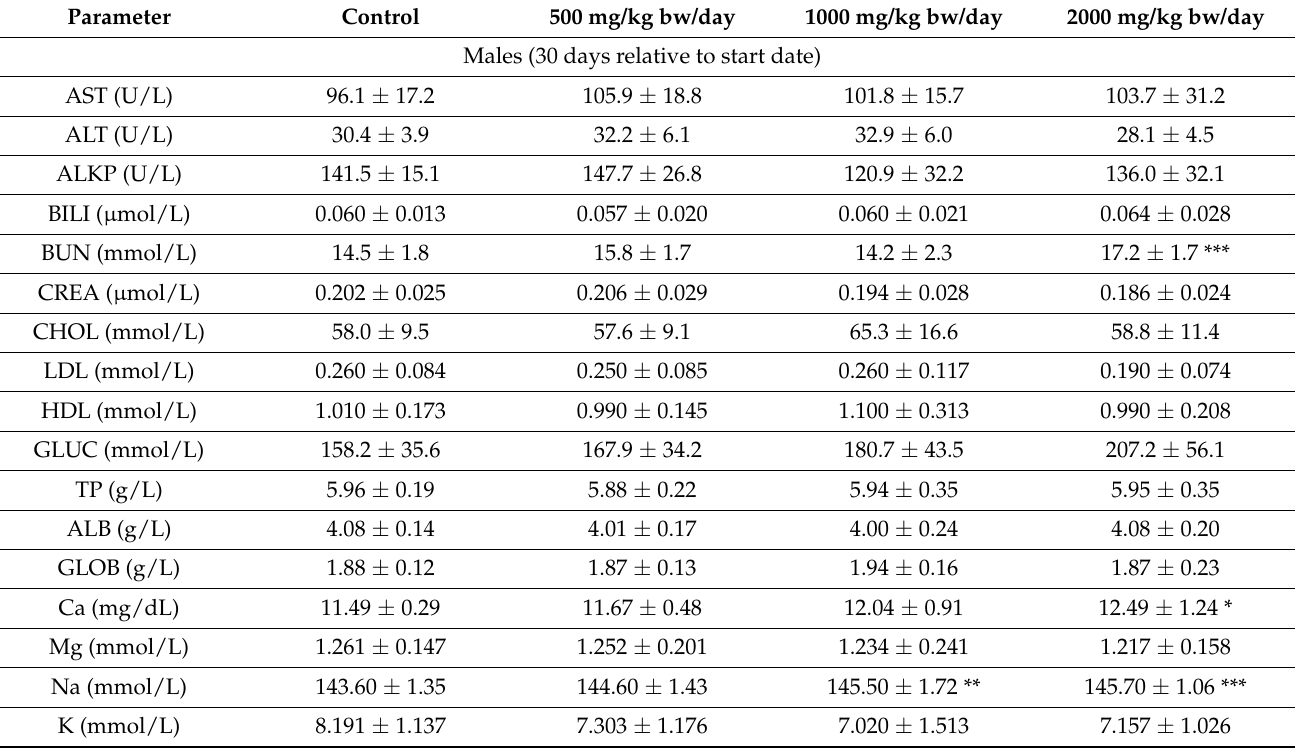
Table 5. Clinical chemistry and thyroid hormone data for the 28-day repeat dose oral toxicity study with